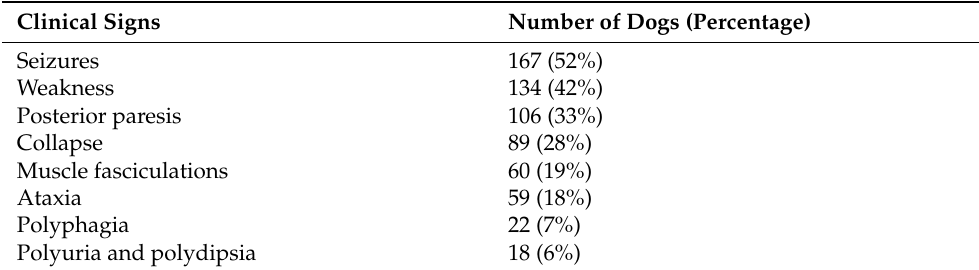
Table 2. Most common clinical signs in 320 dogs with insulinomas